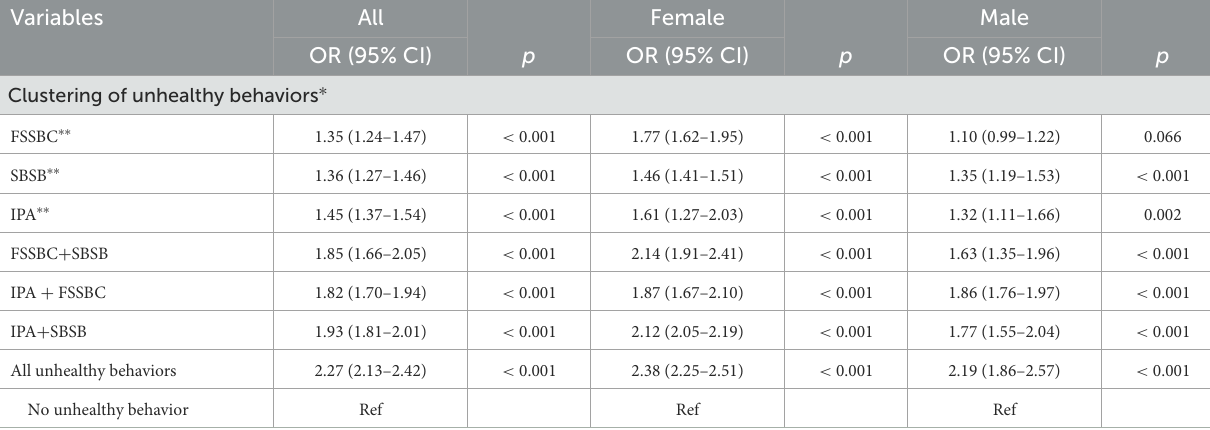
TABLE 3 Generalized linear mixed models demonstrated the association between clustering of unhealthy behaivors and depressive symptoms stratified by sex.